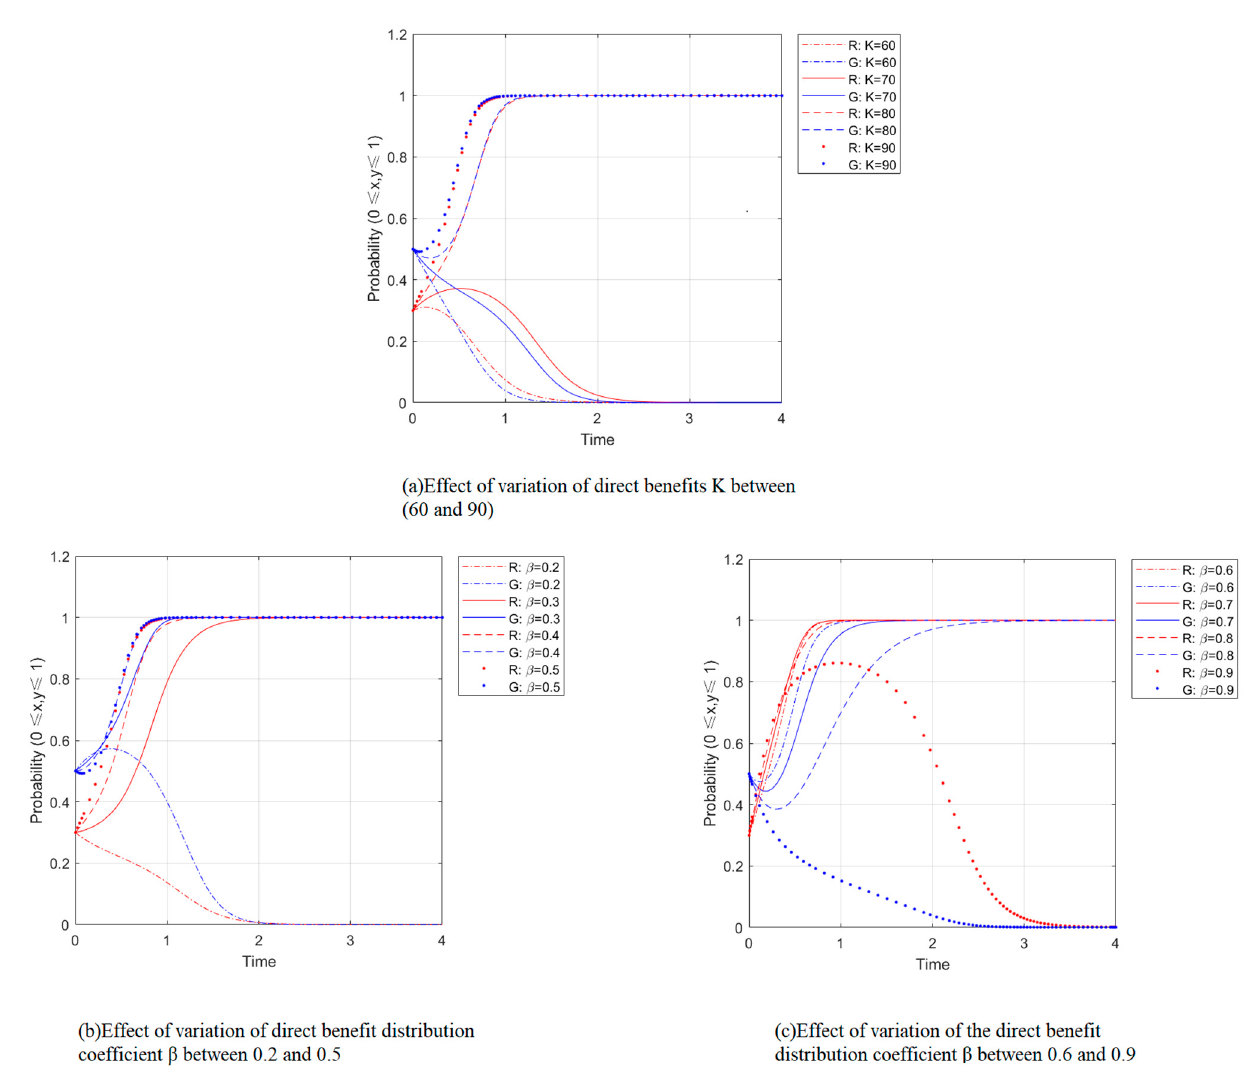
Figure 3. Impact of changes in direct benefits and its distribution coefficient.